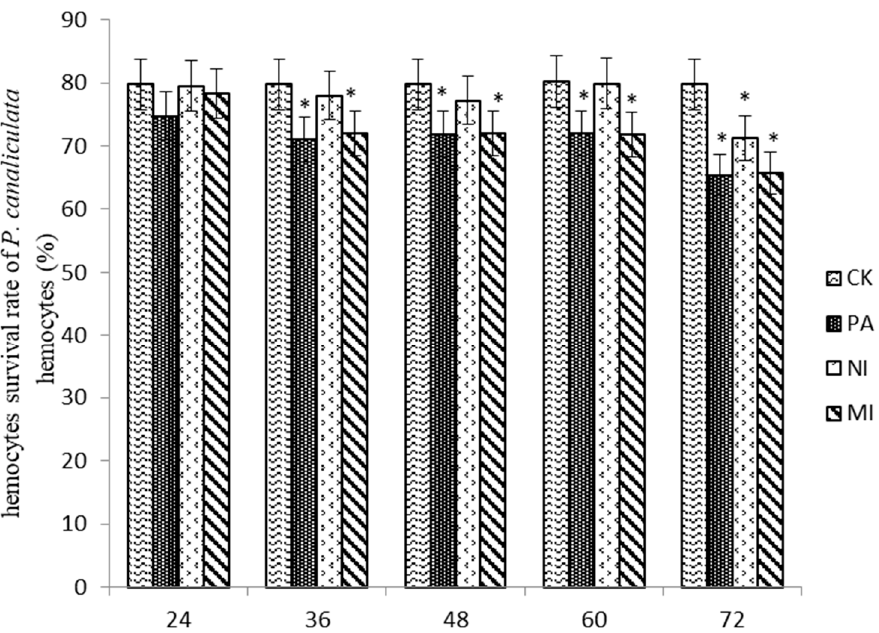
Figure 6. The effect of different treatments on the survival rate of P. canaliculata hemocytes, *— p < 0.05.